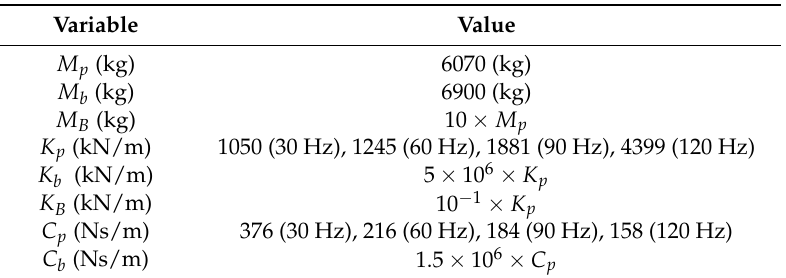
Table 3. Variables used in equivalent electric power plant.